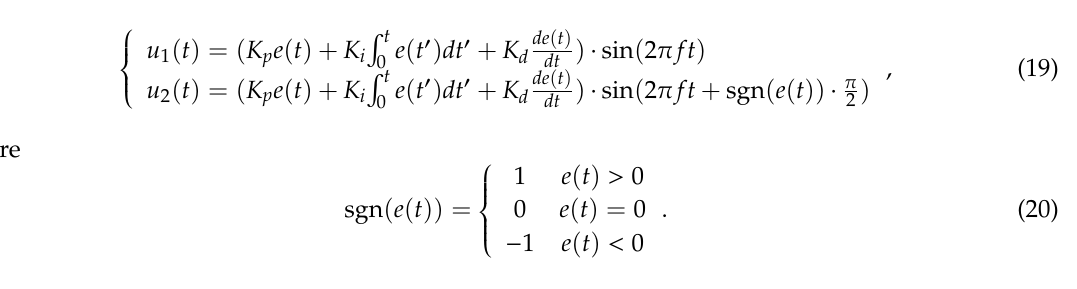
Figure 11. The actuator controller is composed of a series of a PID controllers and an amplitude modulation (AM) + phase modulation (PM) modulator.